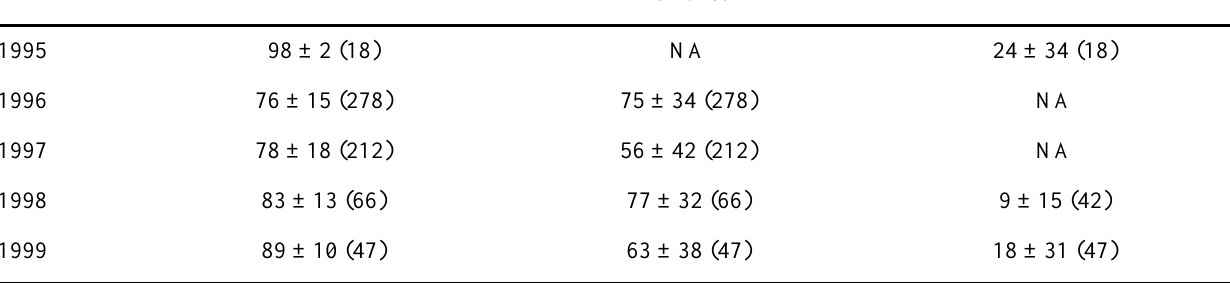
Table 2 . Rates and patterns of amla ( Phyllanthus emblica and P. indofishceri ) fruit harvest in the Yelandur range of the Biligiri Rangaswamy Temple Wildlife Sanctuary, as recorded through participatory monitoring. Numbers in parentheses represent the number of trees